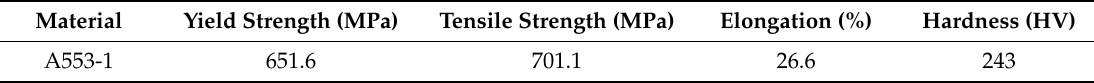
Table 2. Chemical composition of base metal.